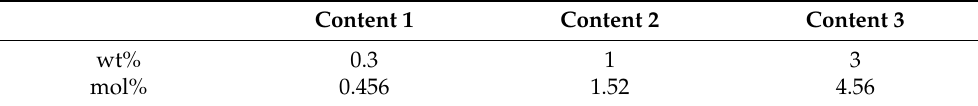
Table 2. Content of AmCl additive in ZnO when applied by the impregnation